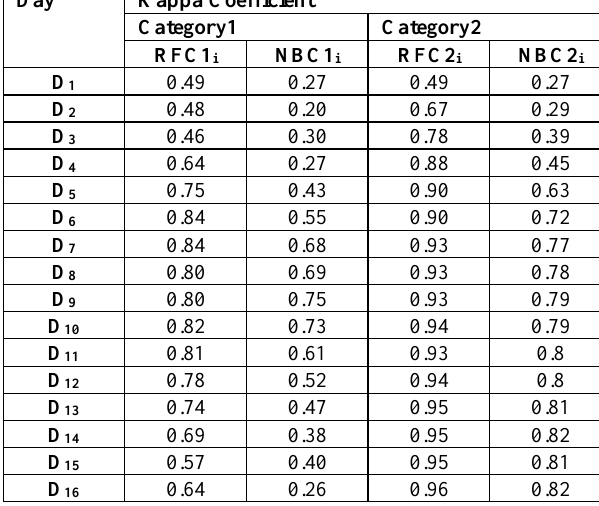
Table 5: Kappa Coefficients of RF and NB classifiers under Category1 and Category2.